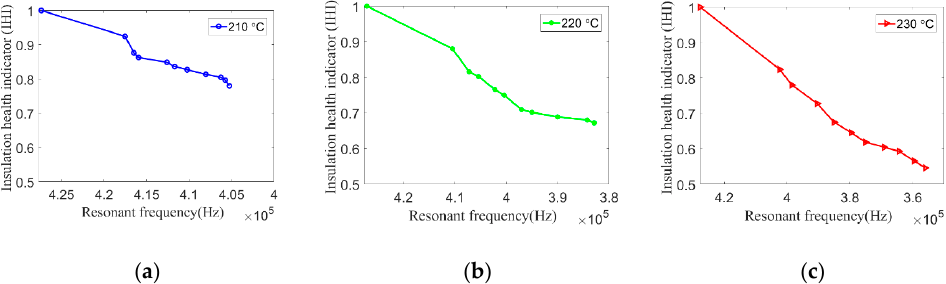
Figure 22. Relationship between insulation health indicator ( IHI ) and resonant frequency under ( a ) 210 °C, ( b ) 220 °C, and ( c ) 230 °C.